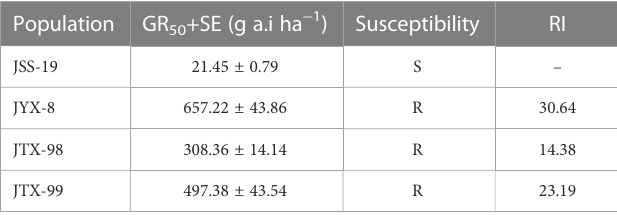
TABLE 4 GR 50 and RI values for four populations of D . ciliaris var. chrysoblephara exposed to metamifop in this study. Population GR 50 +SE (g a.i ha − 1 )